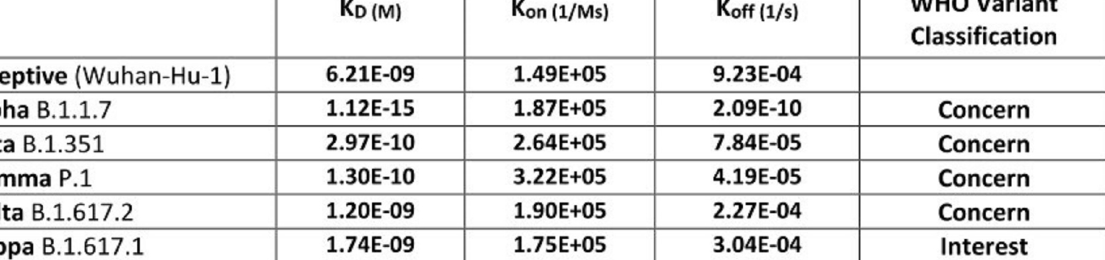
Figure 1. Binding of G921 to viral spike protein variants by bio-layer interferometry. (A) Binding curve for inceptive isolate (Wuhan-Hu-1). (B-F) Variants of concern or variant of interest. (G) G921 binding parameters of the spike protein of SARS-CoV-2 variants relative to the inceptive (Wuhan-Hu-1) isolate as determined by bio-layer interferometry using a 1:1 binding model. Classification of viral variants in right